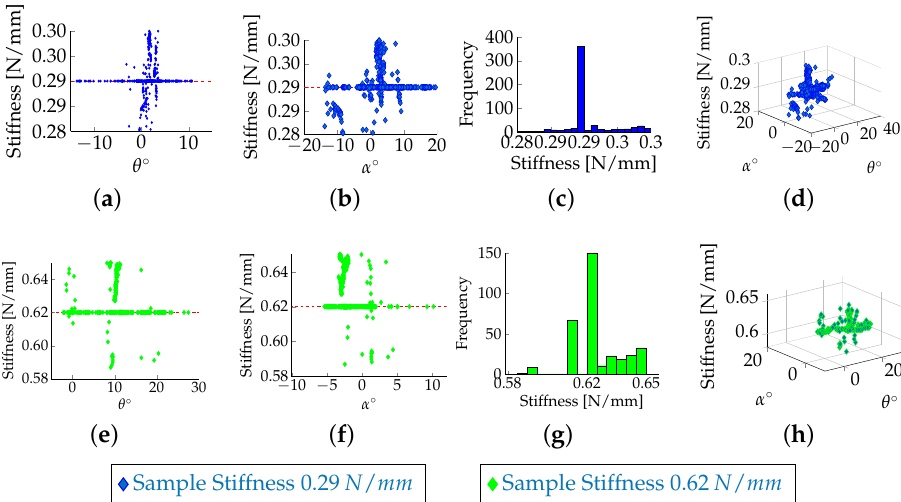
Figure 5. Manual tests for the artificial stiffness samples with spring constant of 0.29 N/mm and 0.62 N/mm: Correlation between the measured stiffness and the orientation of the hand-held probe, which is defined by the pan angle θ ( a , e ) and the tilt angle α ( b , f ); Distribution of the stiffness during the experiments ( c , g ); The stiffness variation in function of the two angles ( d , h ). The mean of the stiffness and the standard deviation are 0.29 and 0.01 for the first sample, and 0.68 and 0.08 for the second.